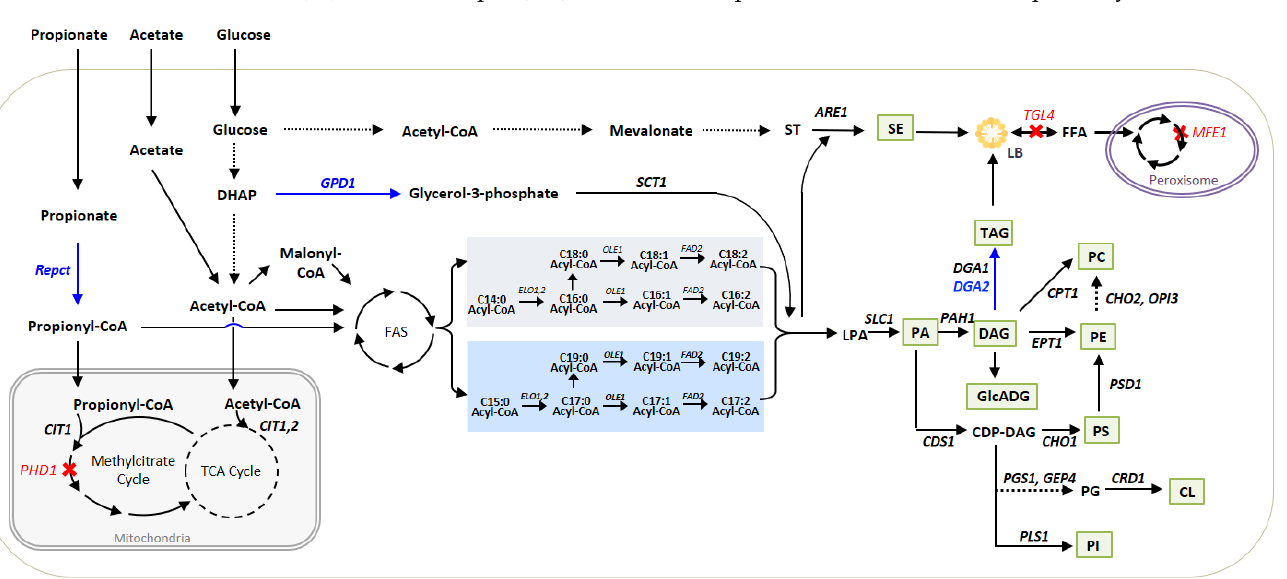
Figure 1. The engineering strategy used in this study to improve the accumulation of odd-chain fatty acids are described in the pathway. The overexpressed genes in the Y. lipolytica strain used in this study are written in blue, and corresponding paths are depicted with blue arrows. The deleted genes are written in red, and corresponding paths are depicted with red cross. The lipid class de- tected in this study are written in green box. The multiple steps in the pathway are depicted as dashed line. Even-chain acyl-CoA pools are in the grey box, and odd-chain acyl-CoA pools are in the blue box. SE—sterol ester; ST—sterol; LPA—lysophosphatidic acid; PA—phosphatidic acid;